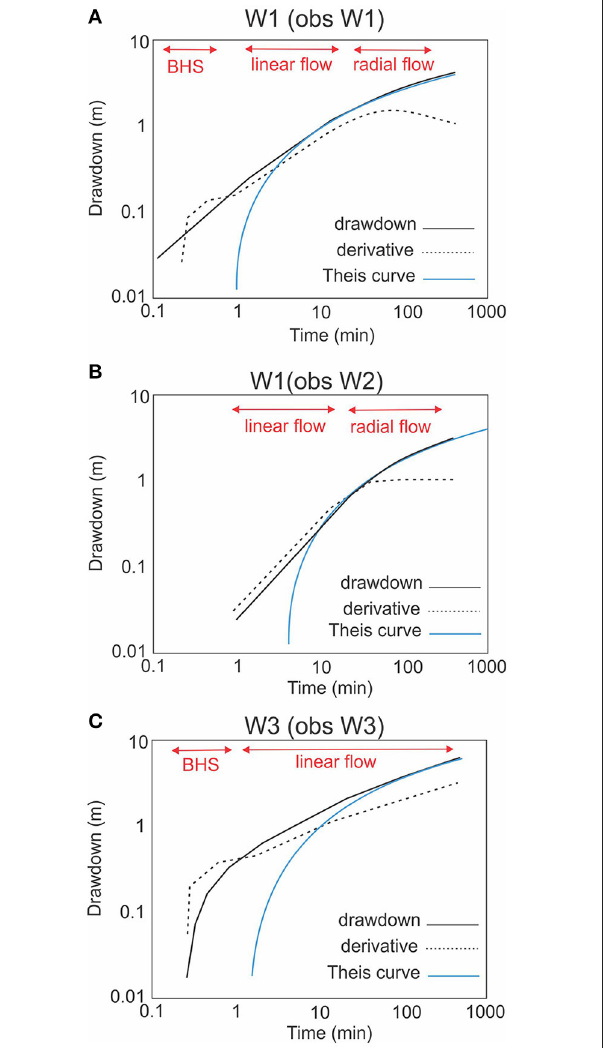
FIGURE 7 | Log-log graphs showing the drawdown curve and the first derivative of drawdown with time along with the Theis curve for comparison for (A) the constant discharge test carried out in W1 with observations in W1; (B) the constant discharge test carried out in W1 with observations in W2 (3m away); (C) the constant discharge test carried out in W3 with observations in W3. (BHS, Borehole